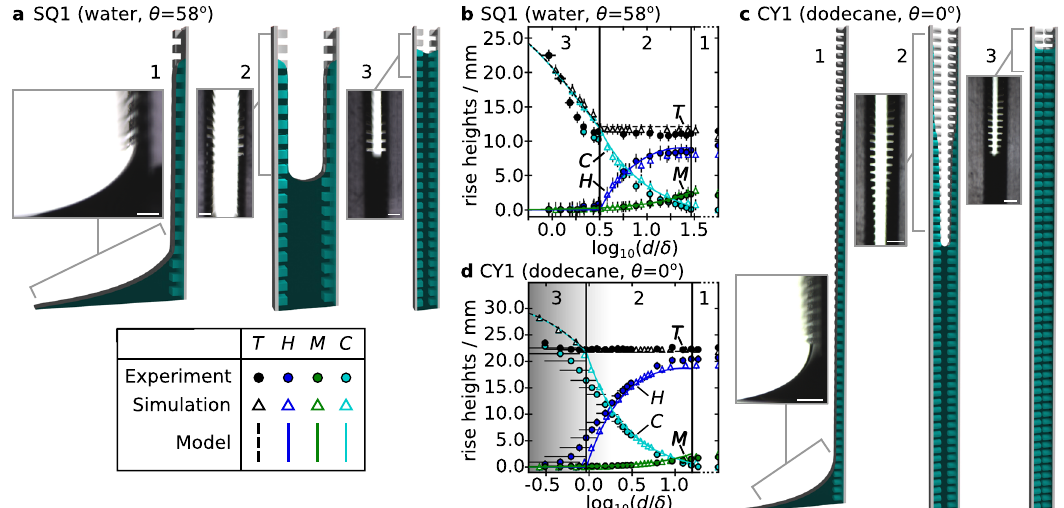
Fig. 2 The variation of the rough capillary rise heights with plate separation, compared between experiments, simulation, and theory. a Examples of the three regimes of rough capillary rise on system SQ1, a square-pillared system with water as the rising liquid (capillary length λ c = 2.7 mm) and contact angle θ = 58°. Full images are simulation results, with insets showing magni fi cations of equivalent experimental systems on the region of interest. Scale bars = 1 mm. b Plot of the variation in the rise heights with plate separation d (normalised relative to the roughness depth δ ) for system SQ1, where δ = 326 μ m, separated into the three regimes. The capillary rise C , meniscus M , hemiwicking H , and total liquid height T , are labelled. Experimental data are shown as fi lled circles, with horizontal error bars indicating measured separation uncertainty, ±50 μ m, and vertical error bars the ±1 post pinning uncertainty, ±709 μ m. Simulation data are shown as empty triangles with vertical error bars indicating the ±1 post pinning uncertainty. Data at the extreme right indicate the rise heights on a single plate, equivalent to in fi nite plate separation. The Dual-Rise predictions are shown as lines. c Example images of the three regimes of rough capillary rise on system CY1, a cylindrically-pillared system with dodecane as the rising liquid (capillary length λ c = 1.8 mm), and contact angle θ = 0°. Scale bars = 1 mm. d Plot of the variation in the rise heights with plate separation for system CY1, where δ = 325 μ m. The shaded region indicates where the separation uncertainty (horizontal error bars) in the experimental data becomes large. The vertical ± 1 post pinning uncertainty is ±458 μ